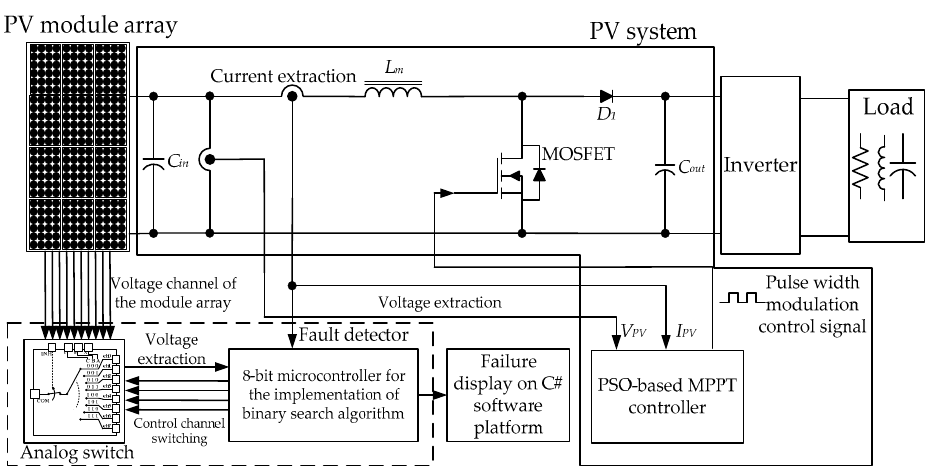
Figure 6. Framework of binary search-based fault diagnosis system for PV modules.